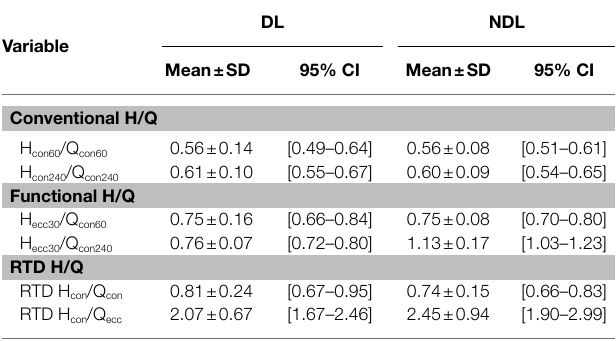
Con, concentric contraction; Ecc, eccentric contraction; 240, 240 ° .s − 1 ; 60, 60 ° .s − 1 ; 30, − 30 ° .s − 1 . All data are presented as mean ± standard deviation with 95% confidence interval.